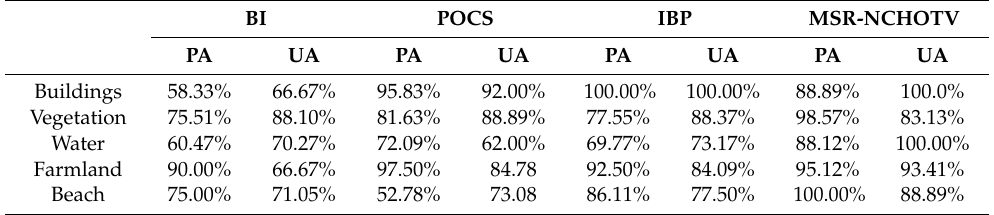
Table 9. The PA and UA of the classification obtained using the SRR images for Experiment 2 for each land cover category.